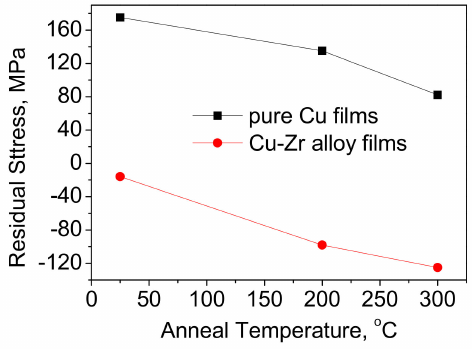
Figure 11. Residual stress as a function of annealing temperature for both pure Cu and Cu-7.3%Zr